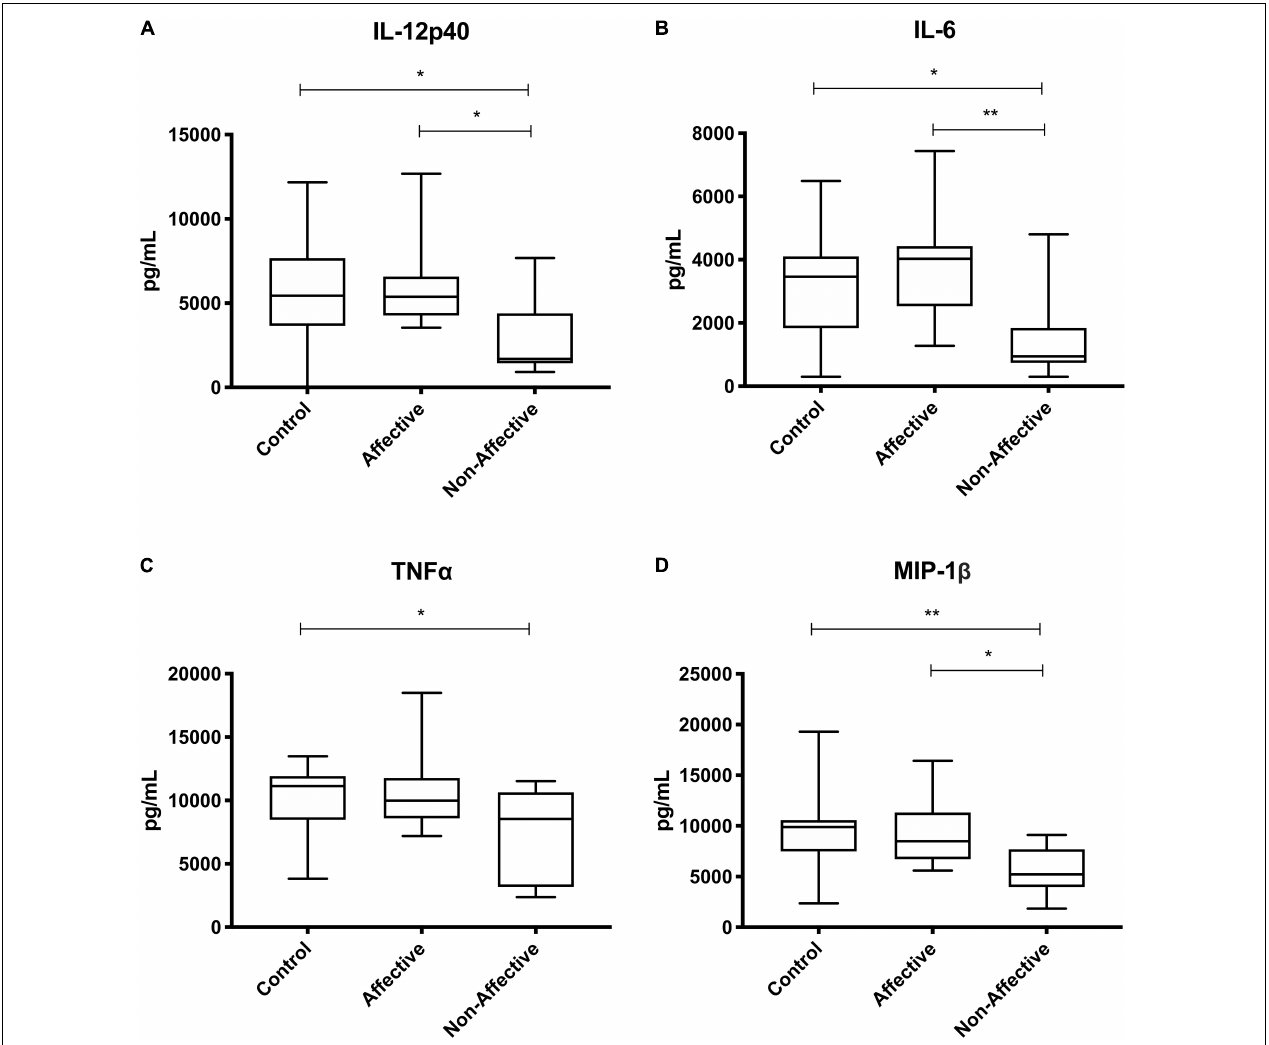
FIGURE 3 | Cytokine/chemokine levels after LPS plus IFN γ stimulation. Macrophage cytokine and chemokine production after culturing for 24 h in RPMI with 10 ng/mL LPS plus 50 ng/ml IFN γ . Macrophages from the NON-group produced decreased concentrations of IL-12p40 (A) , IL-6 (B) , and MIP-1 β (D) compared